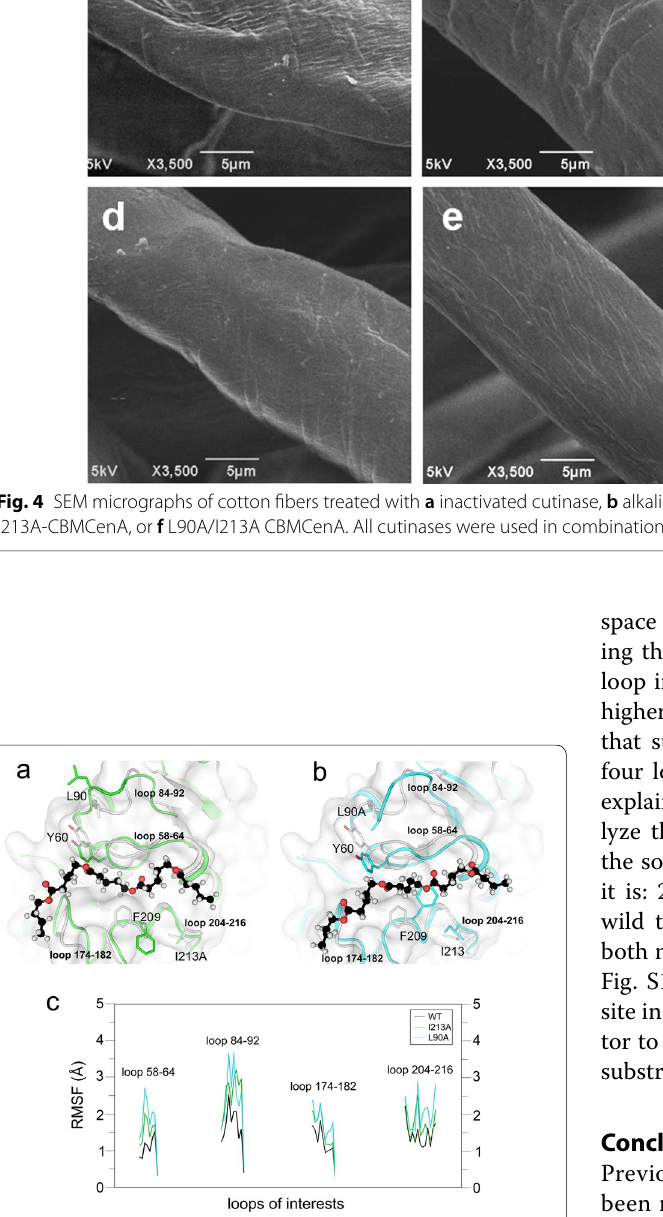
Fig. 5 The conformation of two T. fusca cutinase variants I213A and L90A after MD simulations. The oligoester C 24 H 42 O 8 bound complex structures of I213A ( a ) and L90A ( b ) compared with WT. Four loops, including loop 58–64, loop 84–92, loop 174–182 and loop 204–216 are shown as cartoons and sticks in I213A (green), L90A (cyan) and WT (grey). The substrate C 24 H 42 O 8 is shown as black balls-and-sticks. c The RMSF of these four loops of T. fusca cutinase variants for WT(black), I213A (green) and L90A (cyan) without substrate